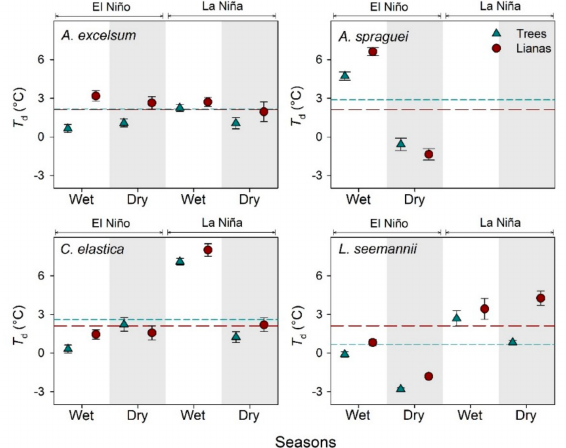
Figure 2. Displayed leaf temperature ( T d ) of lianas and their host tree in four tree species during the wet and dry season in contrasting ENSO years at the canopy of Parque Natural Metropolitano, Panama. Each point represents the mean ( ± SE). Short dashed lines represent the mean of displayed leaf temperature per host tree, while long dashed lines represent the mean of all